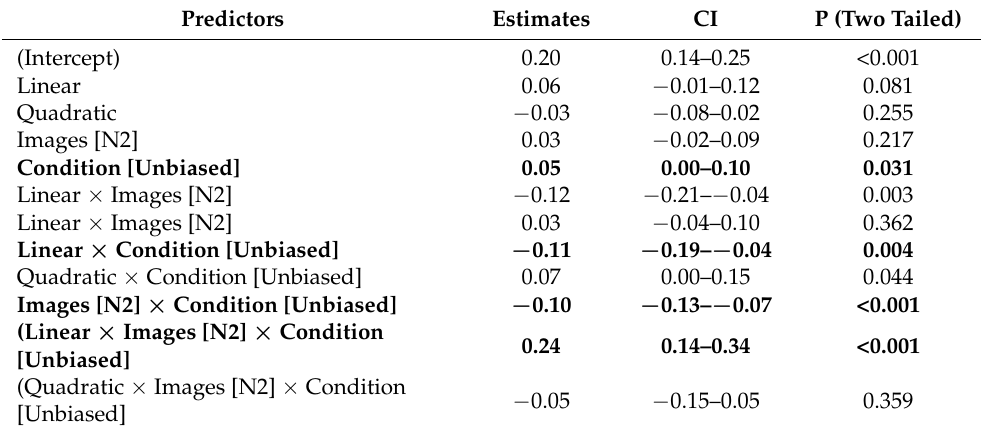
Table 7. Results of GCA analysis of IWA data for time window 4 (processing N2 relative to N1).